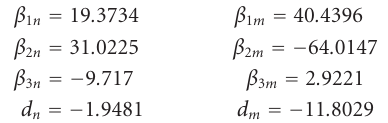
Table 1: Aerodynamic Polynomial Coe ffi cients.